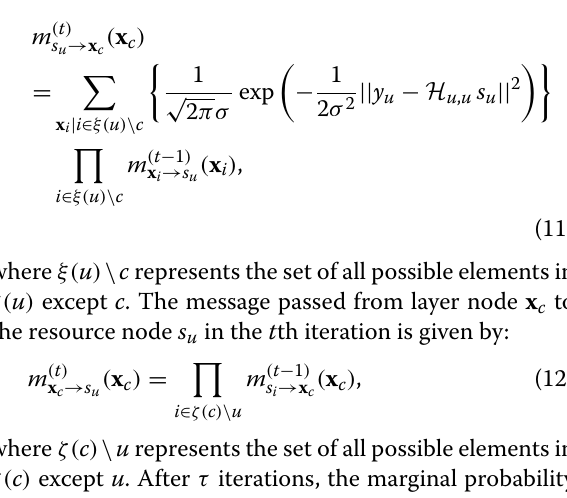
the OFDM subcarriers. The vector d is formed by the concatenation of the vectors s u . Therefore, each cluster of U samples from d k has a direct connection with the corresponding samples of the vector s u . The relationship between s u and x uc is represented by the SCMA factor graph [23], as depicted in Fig. 4, where the resource nodes of a specific cluster represent the k th complex sample of the received signal s u and the layer nodes represent the received codeword x c of the c th